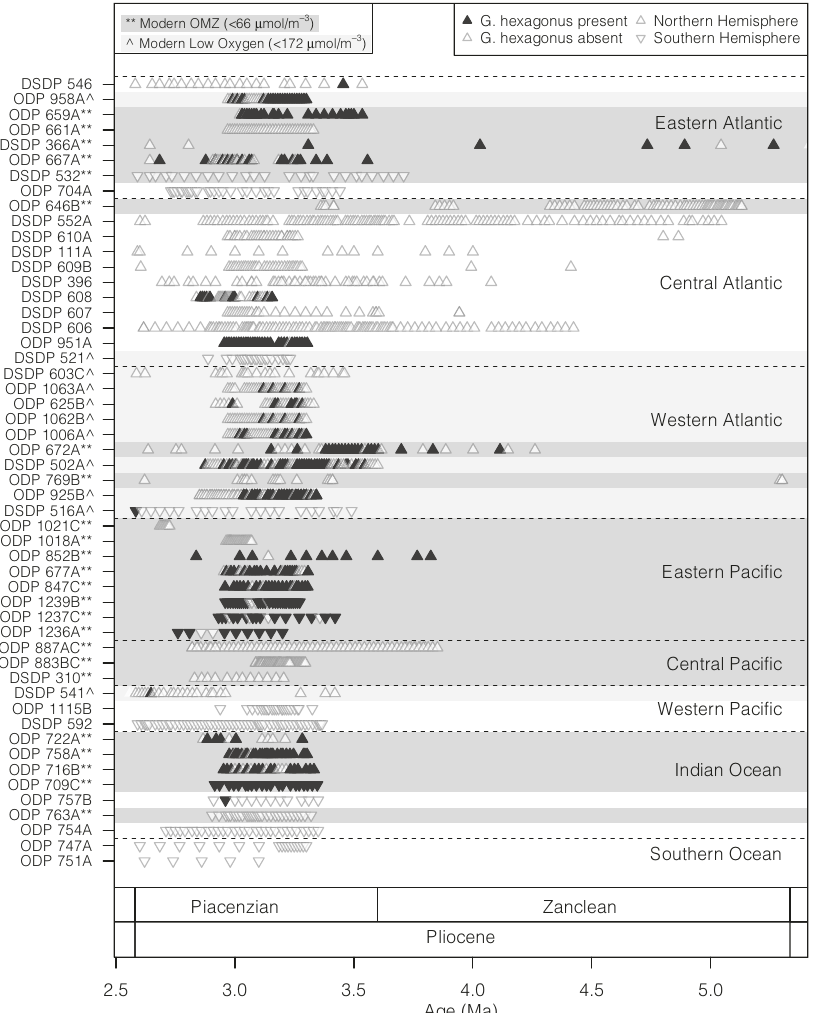
Fig. 4 | Presence/absence of G. hexagonus shells through time. Samples where G.hexagonus waspresentinthePRISMdatabaseareshownas fi lledblacktriangles; samples where G. hexagonus was not found are open gray triangles 41 . Records are organized by region. Sites highlighted by a dark gray box and labeled with a ‘ ** ’ in the y-axis legend are clearly associated with a modern OMZ and